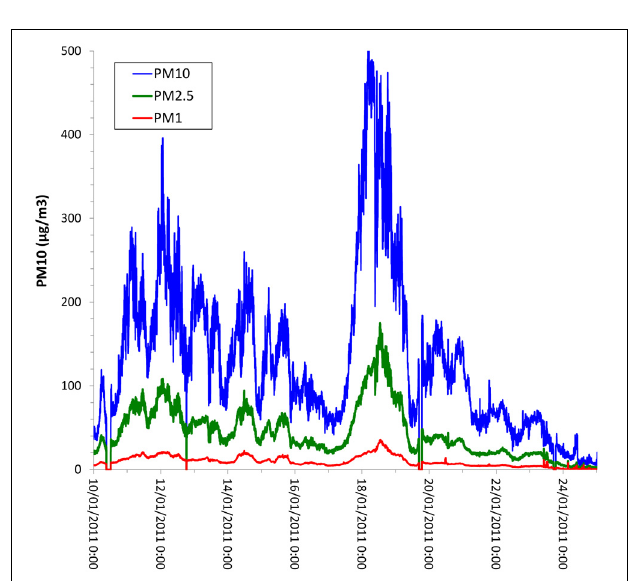
FIGURE 7 | Five minutes averaged PM 1 , PM 2 . 5 , and PM 10 concentration variability of a dust episode during the month of January, 2011.